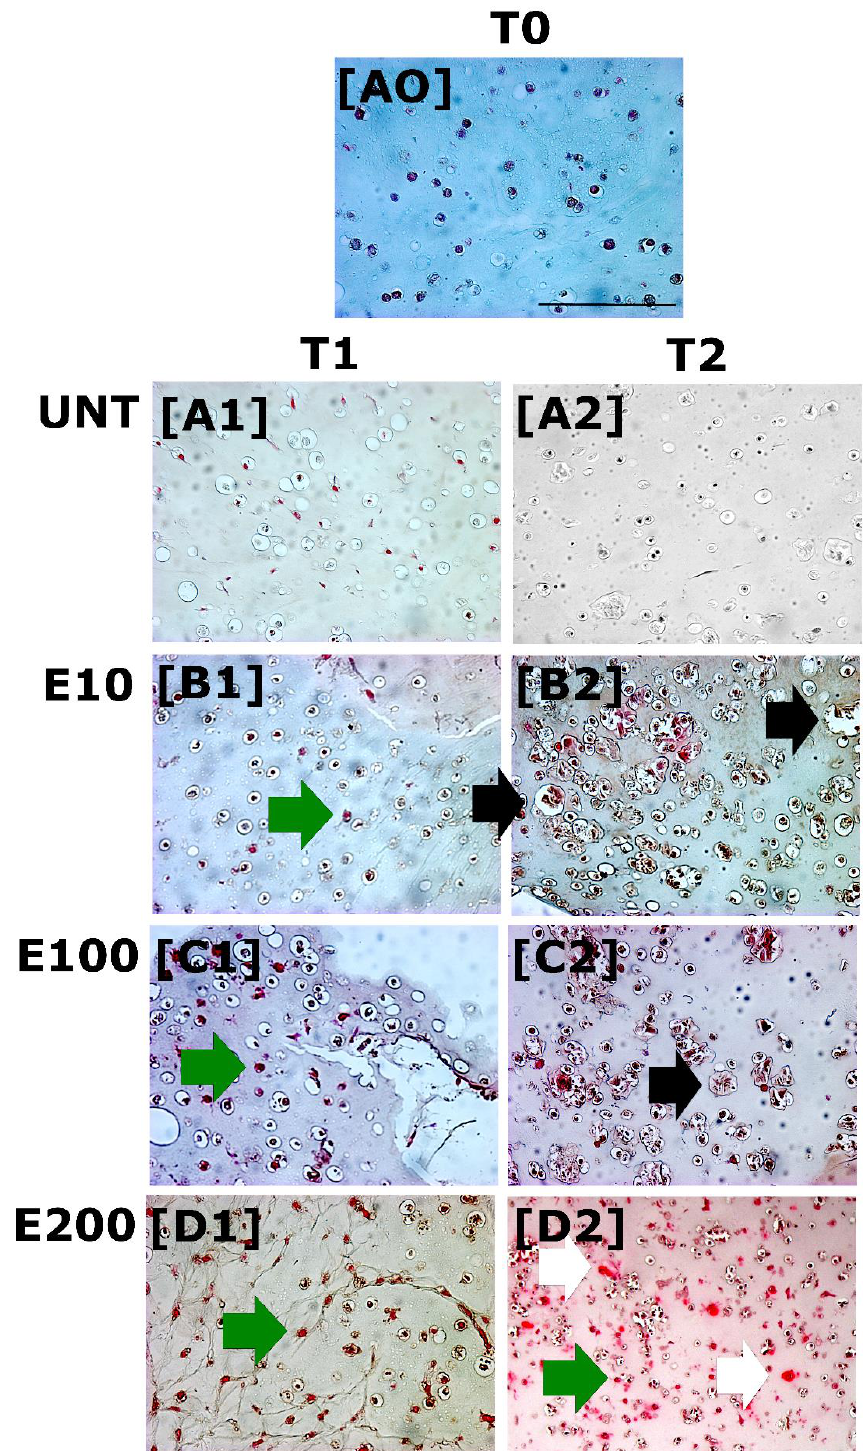
Figure 3. GAGs deposition was evaluated by Safranin-O staining at T0 (d = 0, ( A0 )), T1 (d = 9 days in vitro, ( A1 — D1 )) and T2 (d = 21 day in vitro, ( A2 — D2 )). ( A0 ) UNT group at T0; ( A1 ) UNT group at T1; ( A2 ) UNT group at T2; ( B1 ) E10 at T1; ( B2 ) E10 at T2; ( C1 ) E100 at T1; ( C2 ) E100 at T2; ( D1 ) E200 at T1; ( D2 ) E200 at T2. Green, white and black arrows indicate cellular magenta spots, the territorial matrix and isogenous groups, respectively. Scale bar: 50 µm.